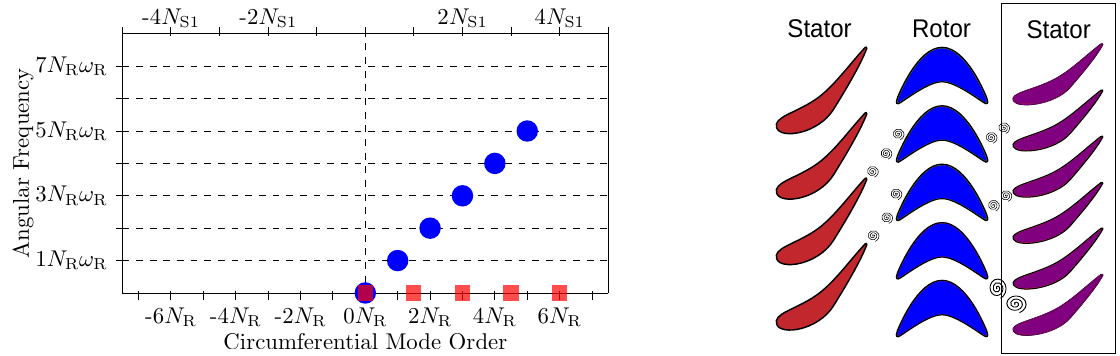
Figure 3. Two harmonic sets representing the disturbances caused by a rotor and a stator. The blade count ratio of the first two rows is